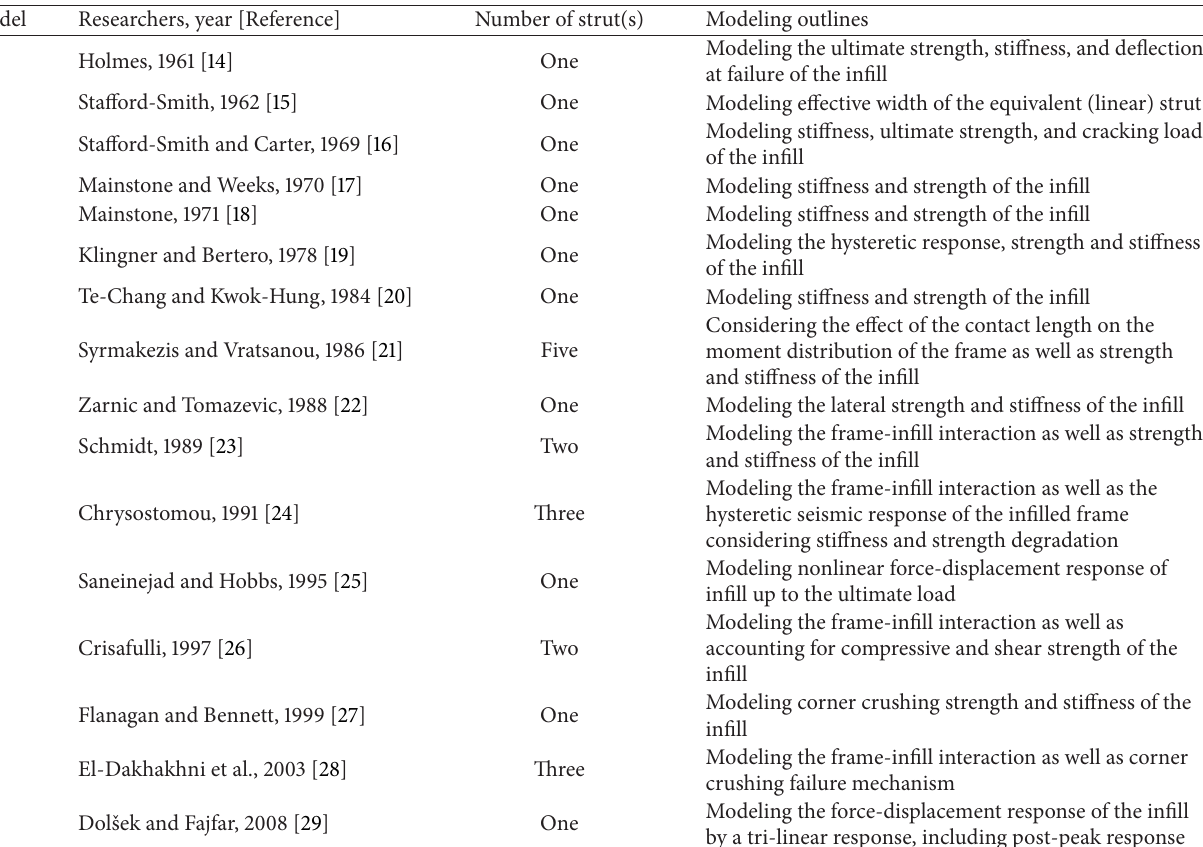
Table 1: Summary of different strut modeling approaches